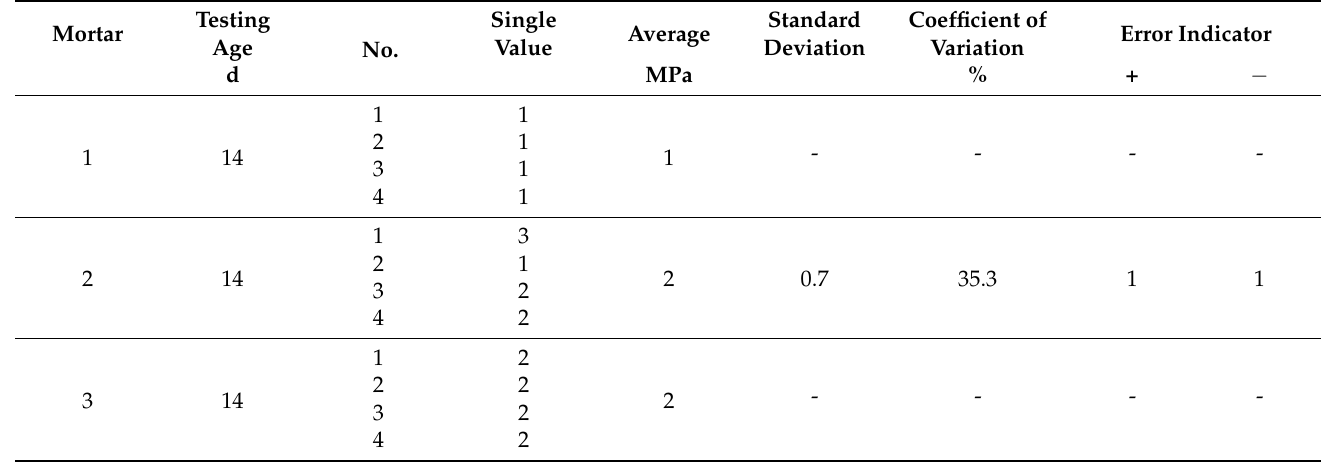
Table A5. Number of cracks, uniaxial tension test, glass textile, Mortar 1–3.